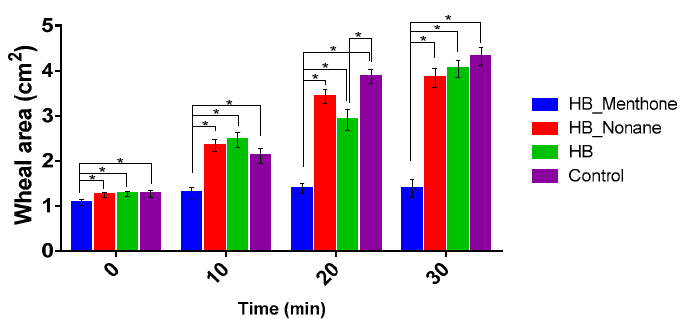
Figure 4. Results of histamine wheal suppression test are represented as mean ± SD. Significant differences are represented with * ( p < 0.005).